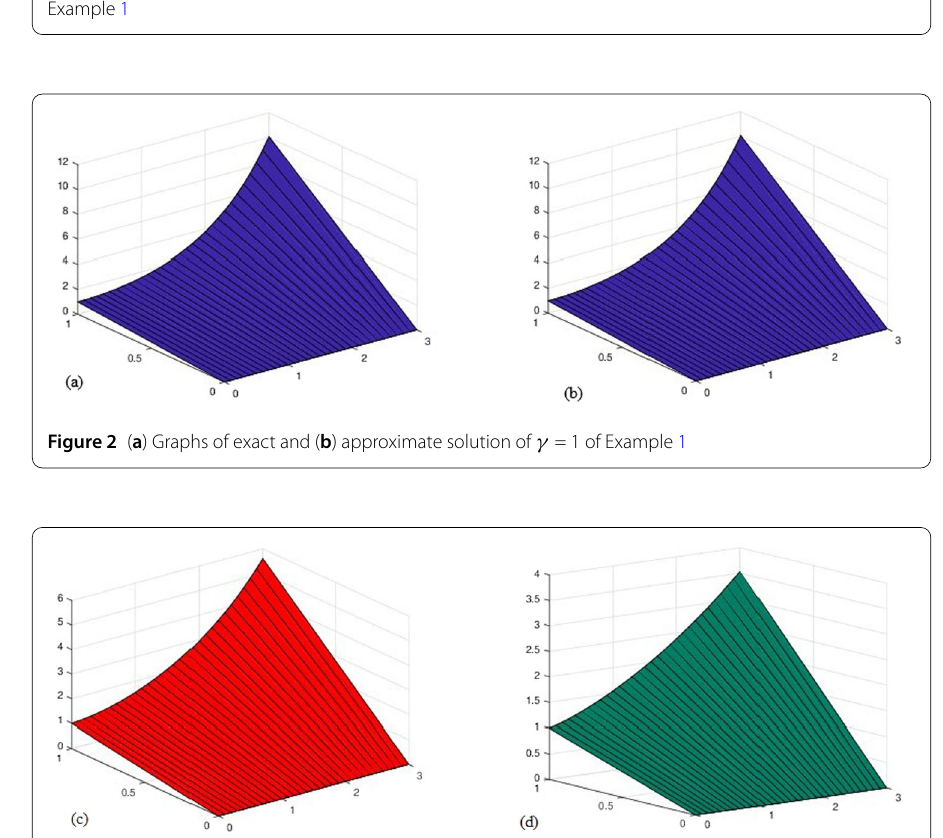
Figure 1 ( a ) Graphs of exact and approximate solution and ( b ) different fractional-order results of γ of Example 1